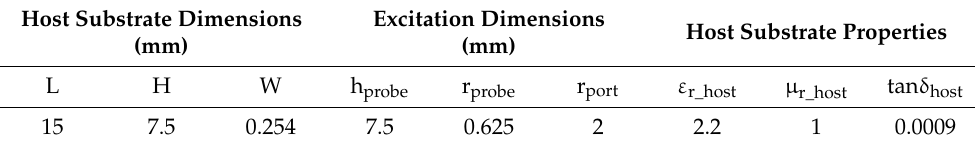
Figure 1. Geometry of the low-loss host substrate of width (W), length (L), and height (H): ( a ) Front view ( Host substrate, Probe); ( b ) Top view; ( c ) Left side view; ( d ) Excitation magnetic field in the substrate. (Ground plane not shown in all four sub-figures, and probe not shown in ( d )). Table 1. Specifications of the host substrate and excitation probe. Table 1. Specifications of the host substrate and excitation probe.